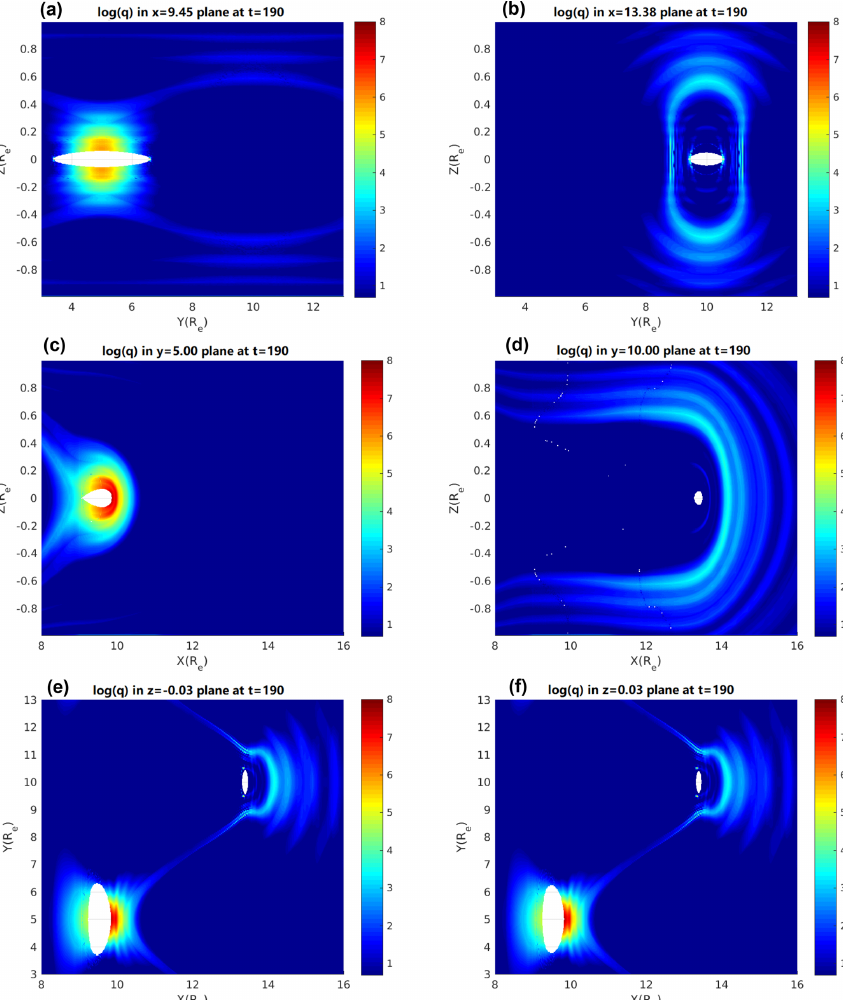
Figure 9. Contours of the logarithm of squashing degree in the x = 9 . 45 and x = 13 . 38 planes (a–b) ; in the y = 5 and y = 10 planes (c–d) ; and in the z = − 0 . 03 and z = 0 . 03 planes (e–f) at t =